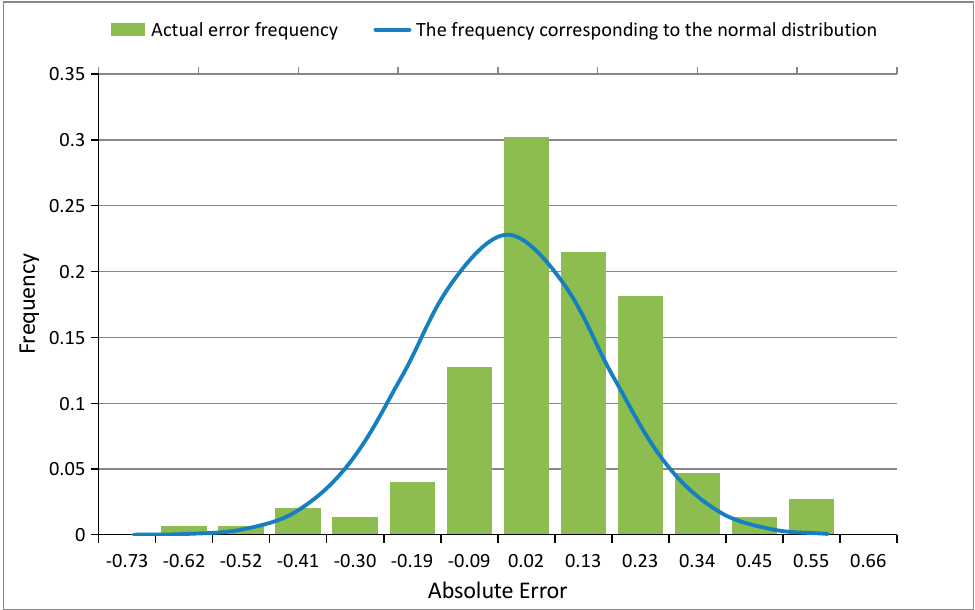
Figure 4. The absolute error frequency histogram and the corresponding normal function curve.